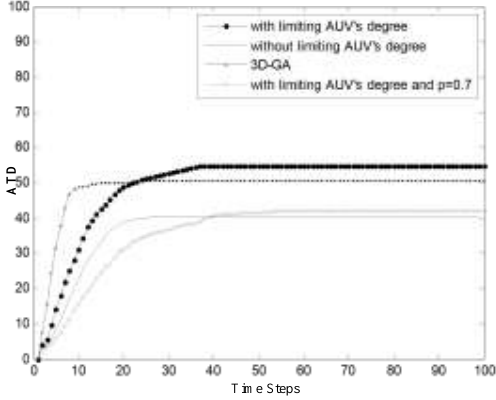
Figure 11. NVS vs. time step for scenarios 1-3 and